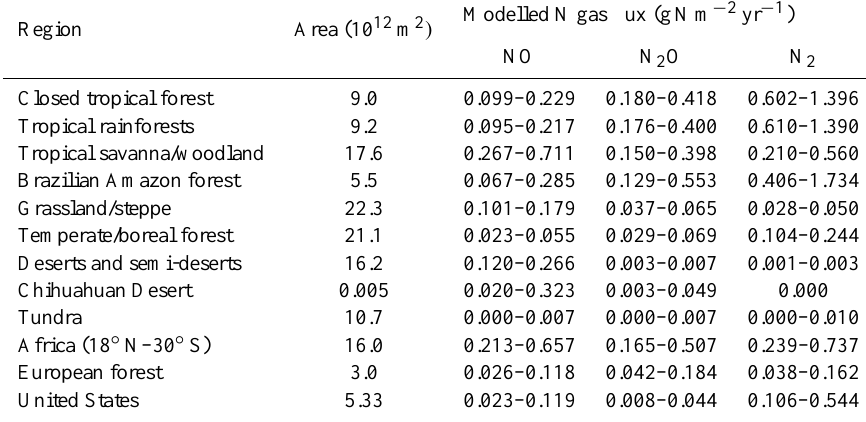
Table 2. Modelled results of regional N gas fluxes from soil